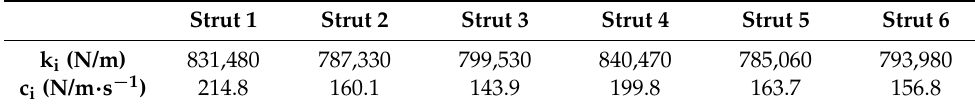
Table 2. Stiffness and damping coefficients of the struts.